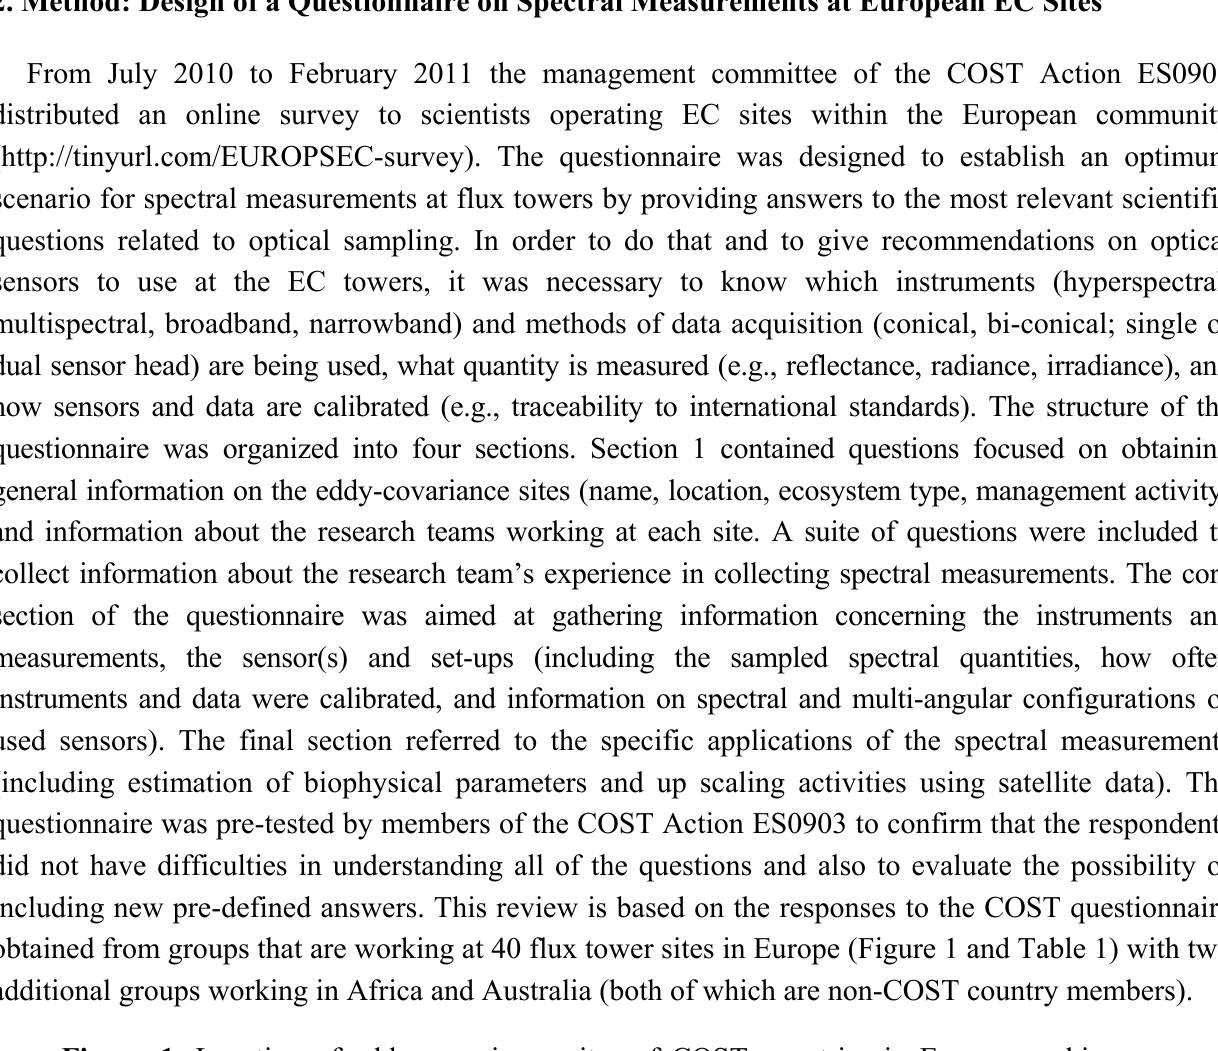
Figure 1. Location of eddy covariance sites of COST countries in Europe working on spectral measurements that filled the